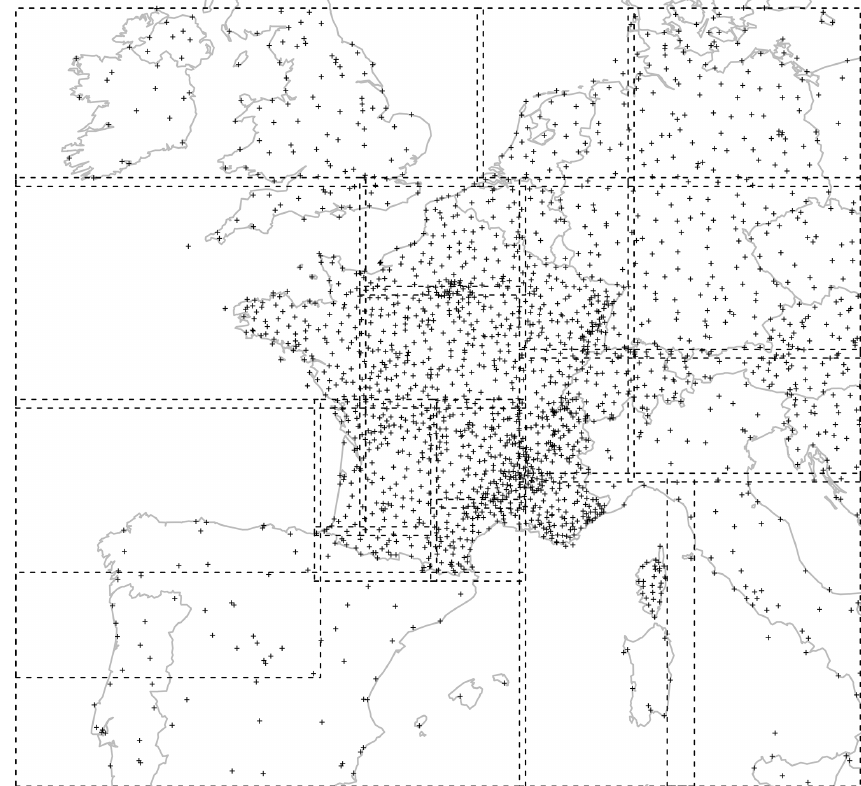
Figure 6. Domains used for spatialization of post-processed